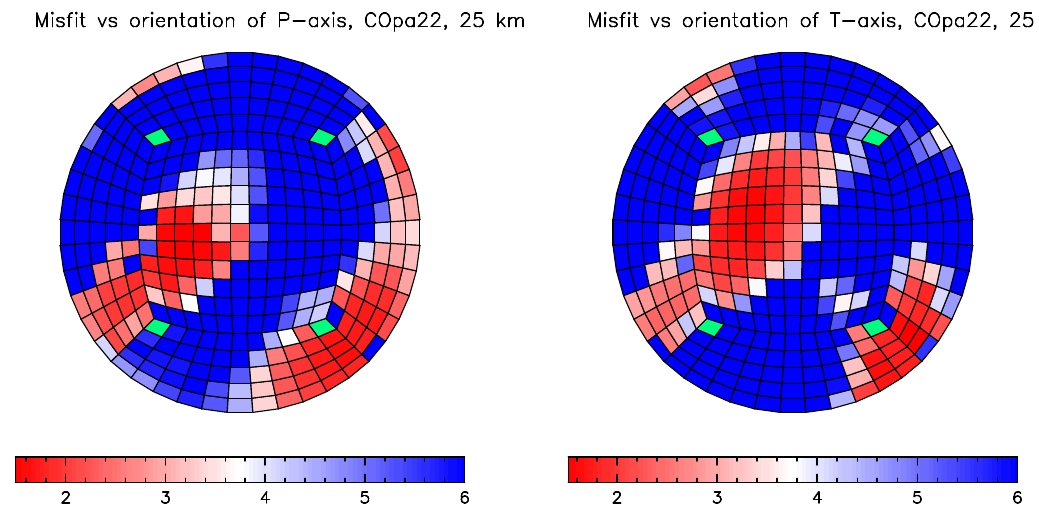
Figure 12. Smallest misfit achievable for fault plane solutions with (left) P axes or (right) T axes piercing the focal sphere at a given bin. Source depth is 25km. Location of Comninakis and Papazachos (1986) was used for the waveform grid search. Focal sphere is mapped on the horizontal plane using a Lambert–Schmidt projection as commonly done when plotting beach balls. North is directed upwards and east is directed to the right. Color scale is truncated at a waveform misfit of 6.